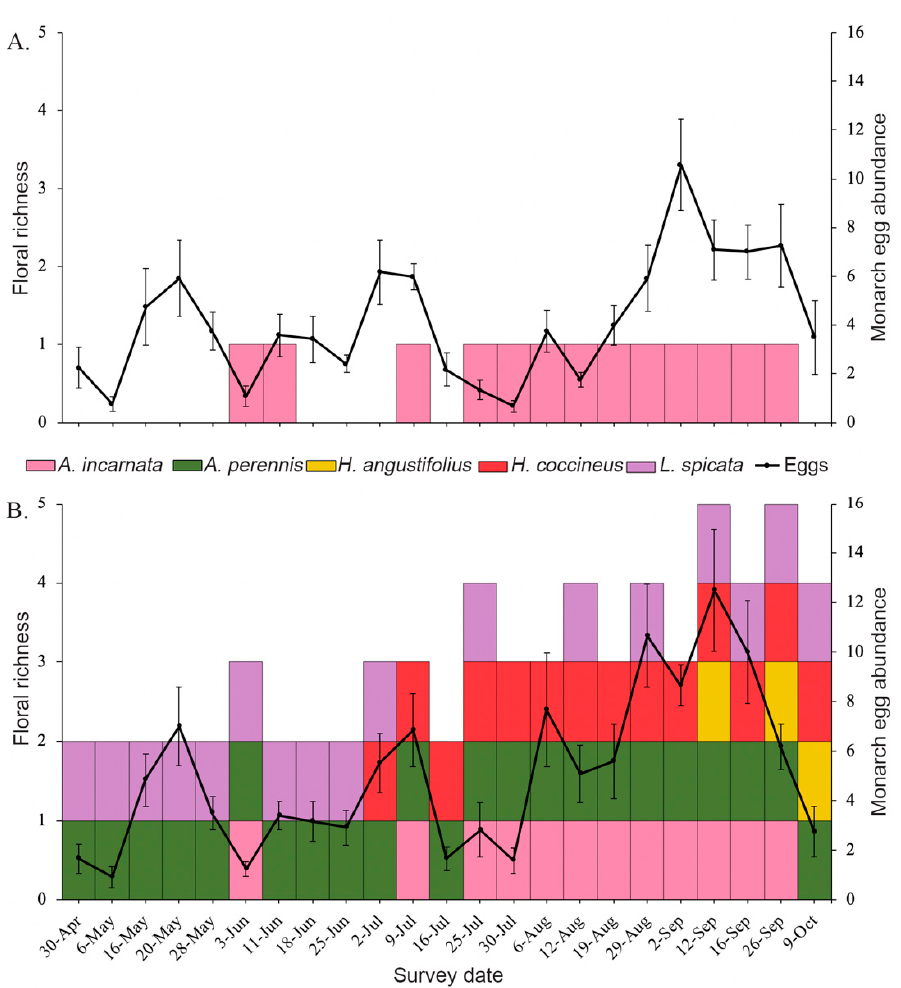
Figure 2. Depiction of floral presence, floral phenology, and monarch oviposition over the duration of the study period between ( A ) swamp milkweed monoculture plots and ( B ) mixed-species plots. The left y-axis shows the number of wildflower species in bloom, indicated by the species-specific colored boxes. The right y-axis shows average weekly monarch egg abundance per focal milkweed plantings, indicated by the solid black line. Error bars represent standard error.